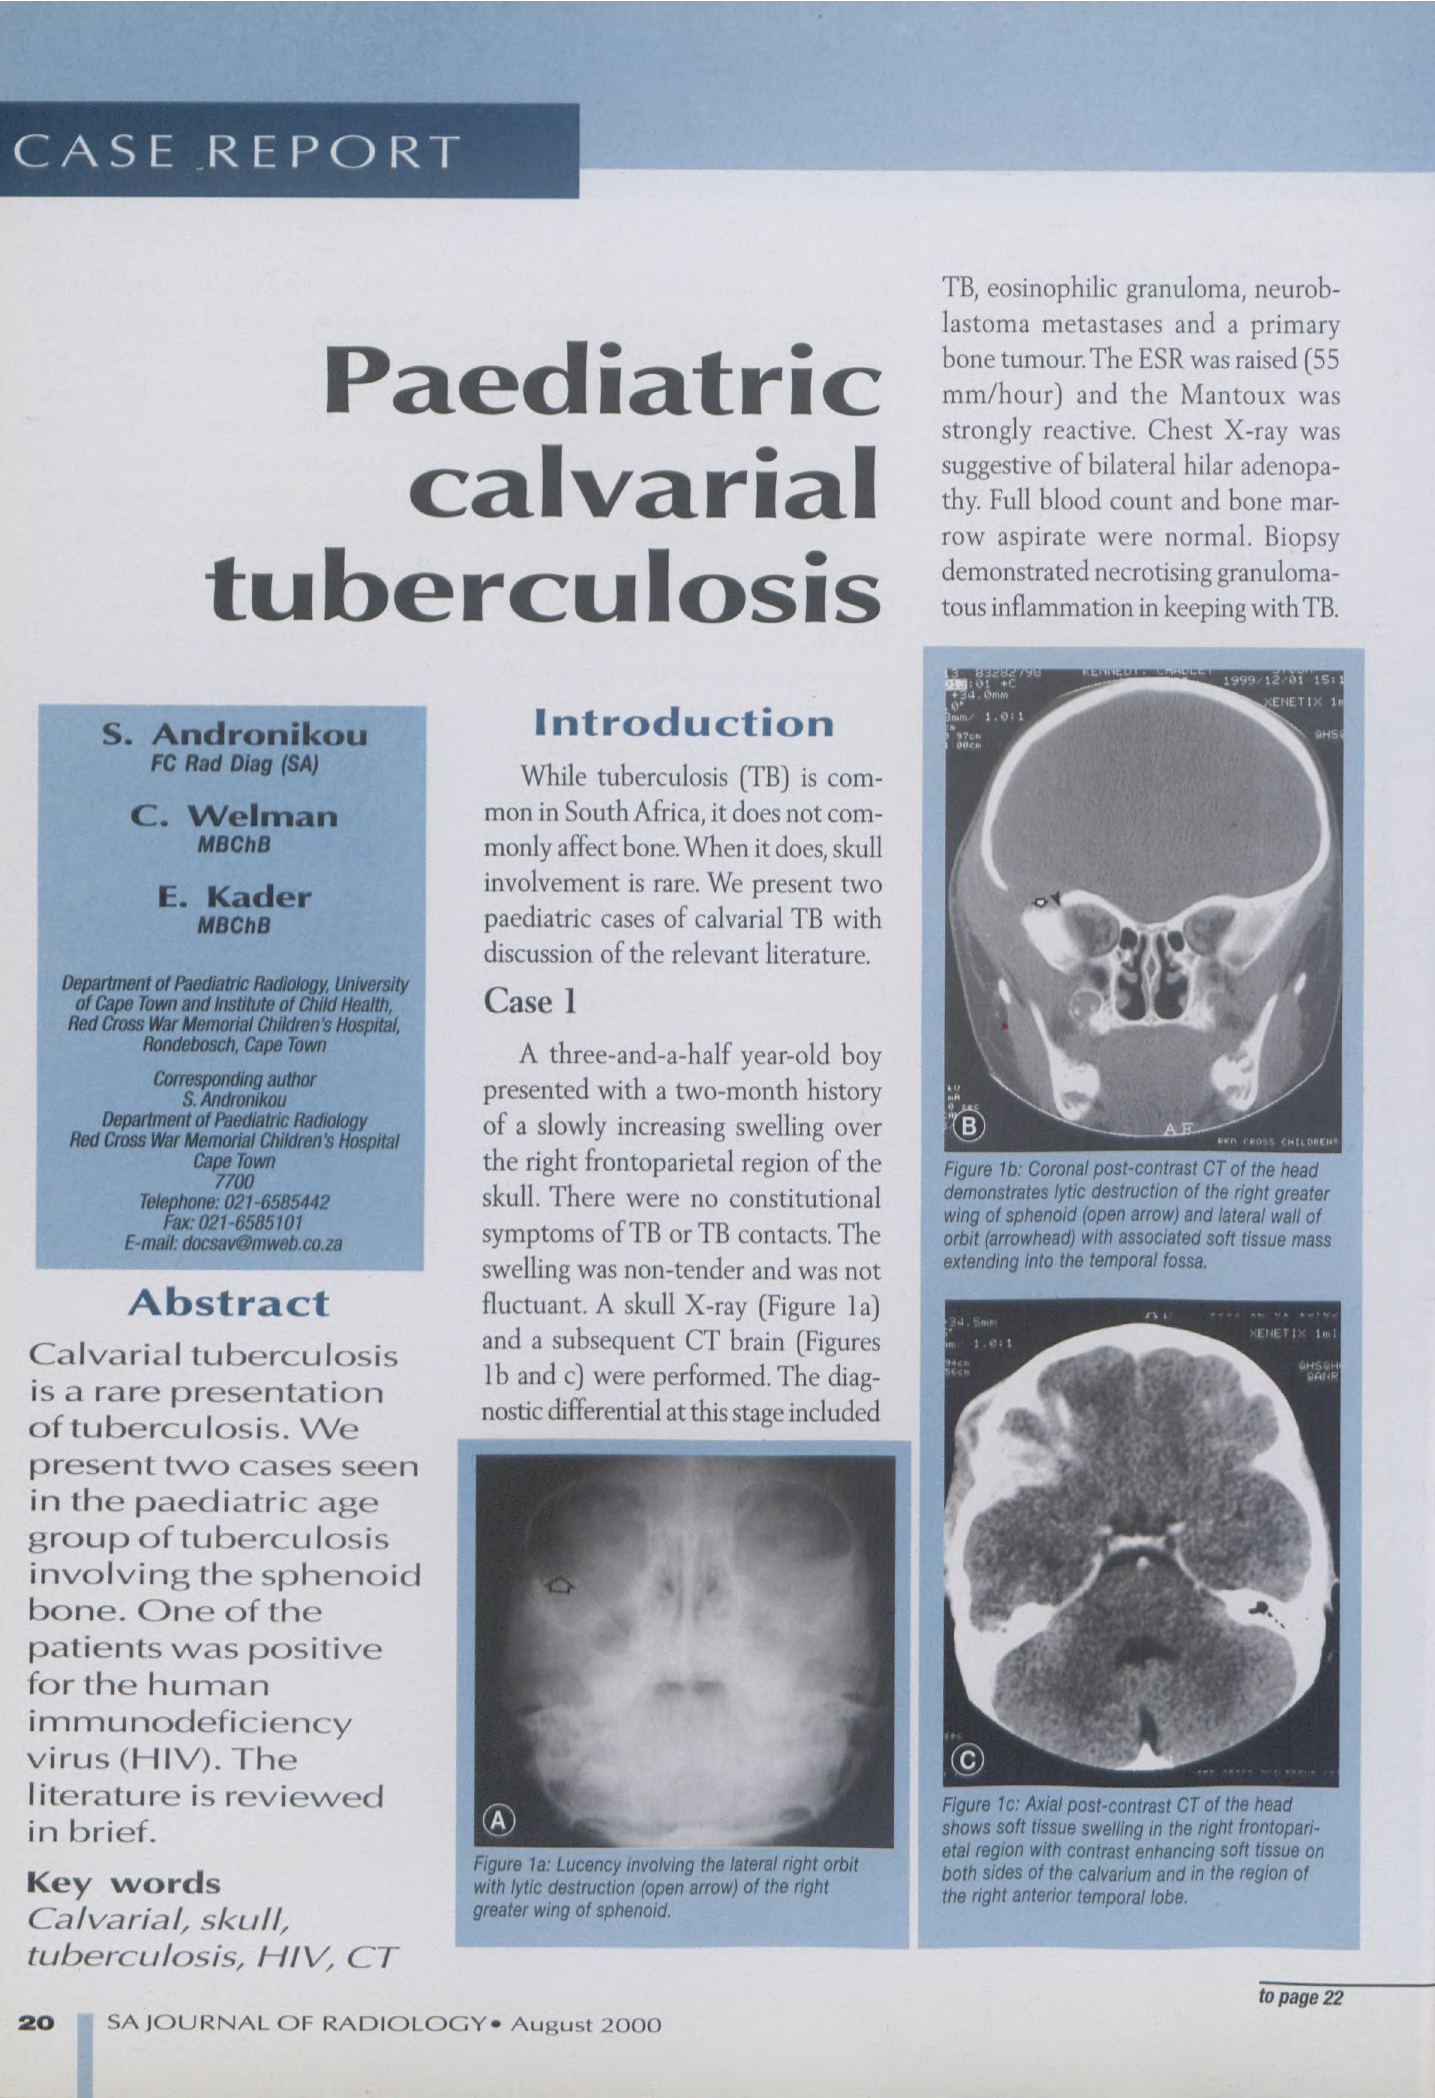
Figure la: Lucency involving the lateral right orbit with lytic destruction (open arrow) of the right greater wing of sphenoid.